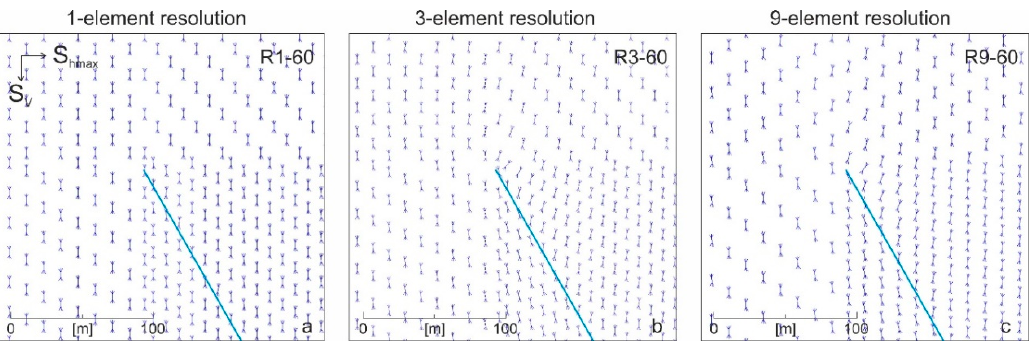
Figure 8. Detailed view of the orientation of the maximum principal stress (S 1 ) after the last load step for 1-element- ( a ), 3-element- ( b ) and 9-element- ( c ) wide fault zones dipping at 60° and using a rectangular grid.